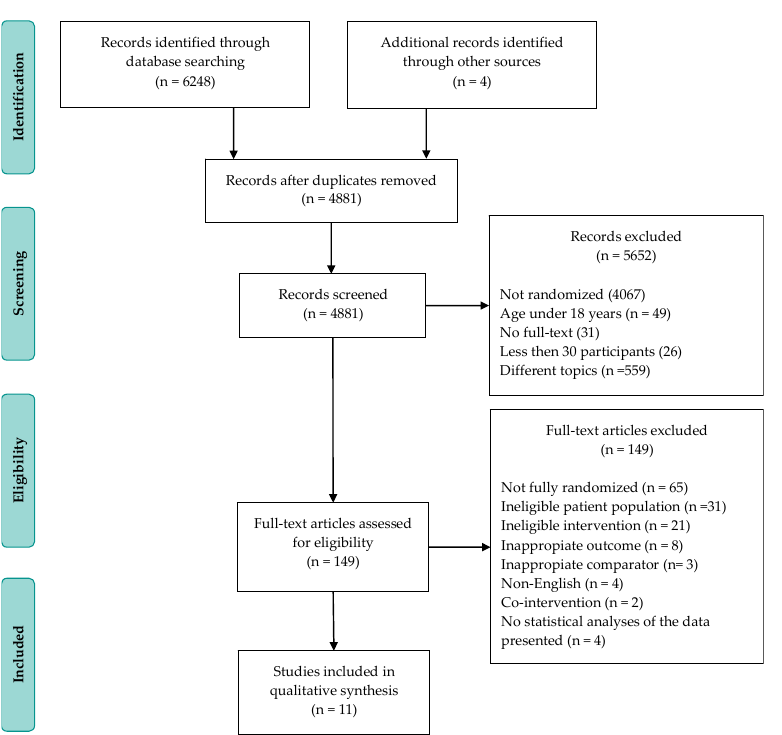
Figure 1. Flow diagram showing selection process.